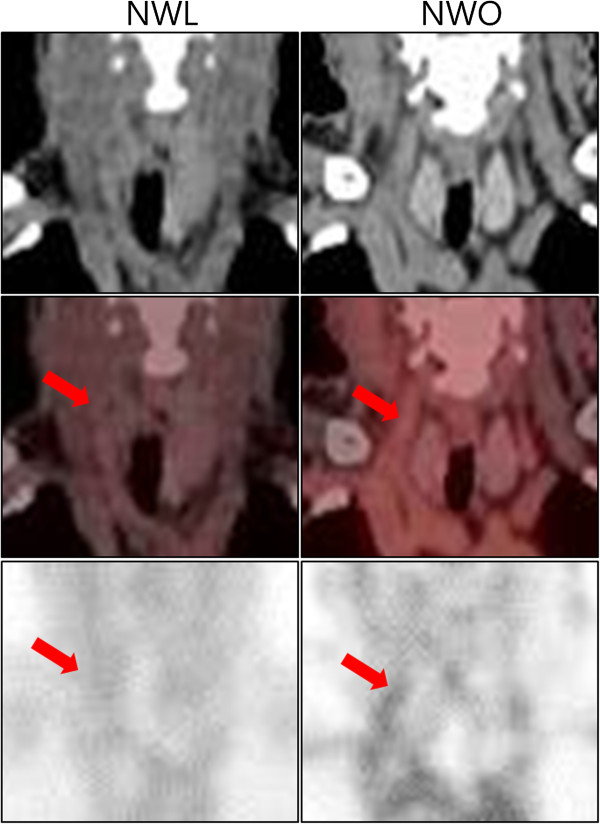
Representative figures indicating the SUV uptake at the carotid artery in NWL and NWO subjects. Coronal image of 18 F-FDG-PET/CT around the carotid artery is presented as an unenhanced CT image, a fusion image of CT and PET, and a maximum intensity projection (MIP) image, from the upper panel to the lower panel. The red arrow indicates the carotid artery. 18 F-FDG-PET/CT, 18 F-fludeoxyglucose positron emission tomography/computed tomography; SUV, standardized uptake value; NWL, normal weight lean; NWO, normal weight obesity.